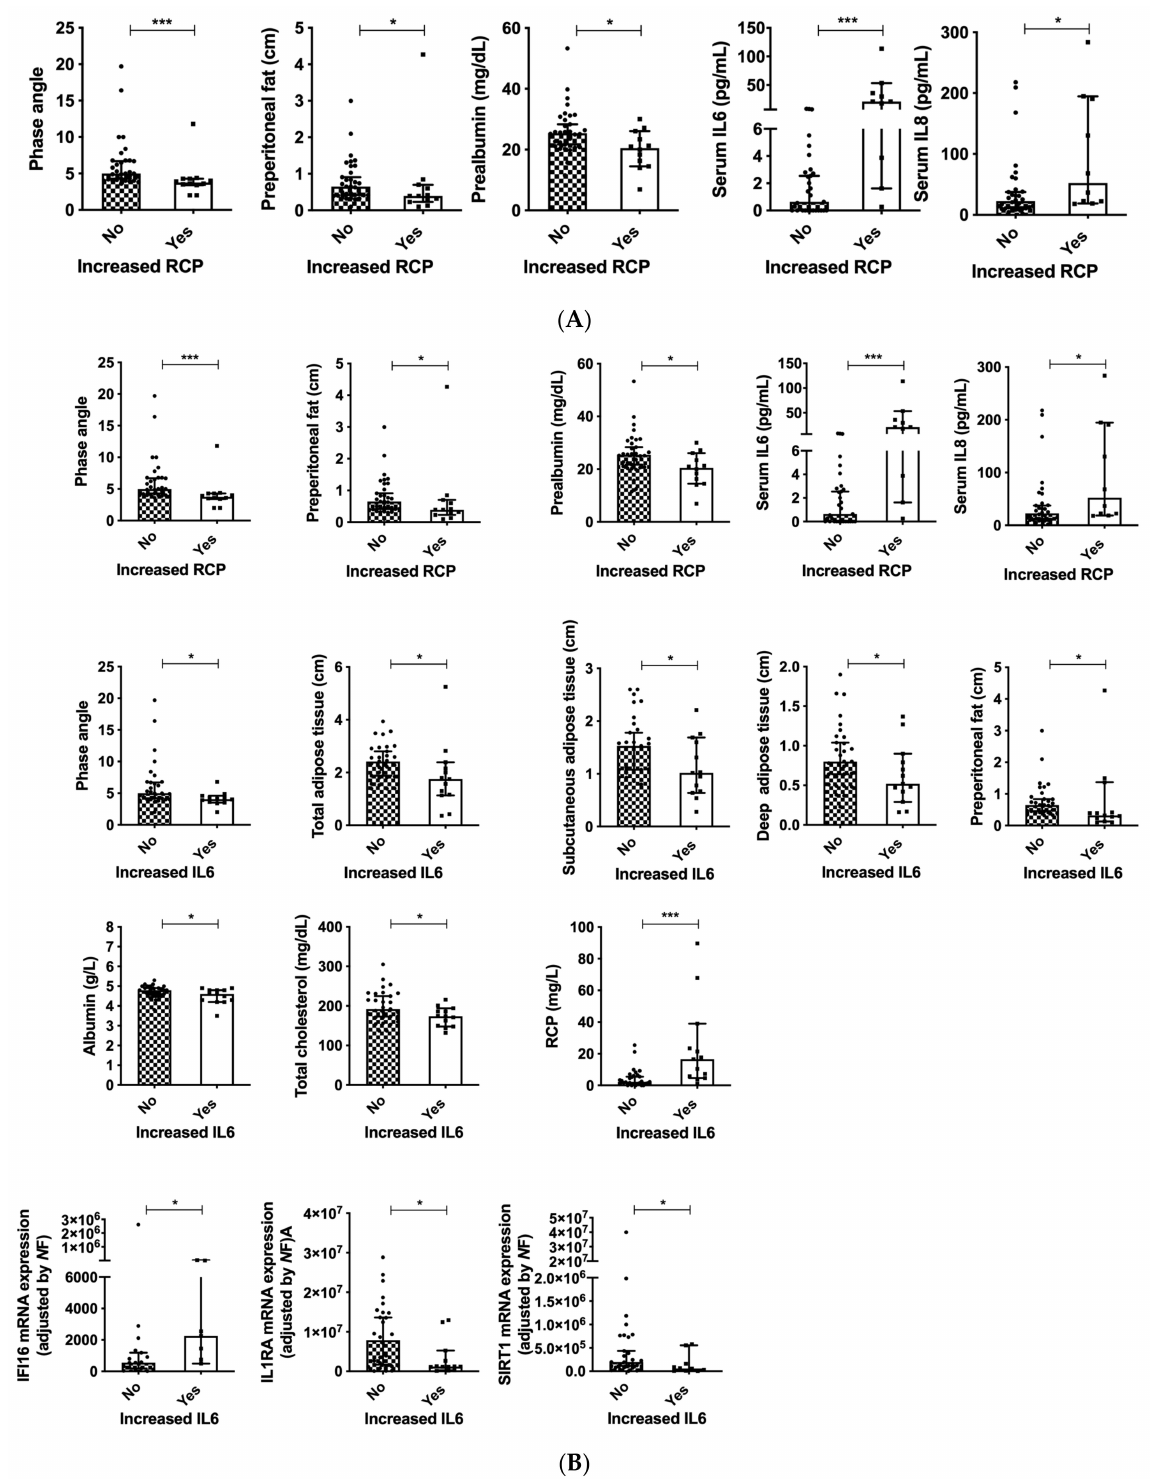
Figure 7. Clinical and biochemical associations in patients with increased serum inflammation markers and head and neck cancers. ( A ) Increased RCP; ( B ) Increased serum IL6. Legend: *: p < 0.05; *** p <